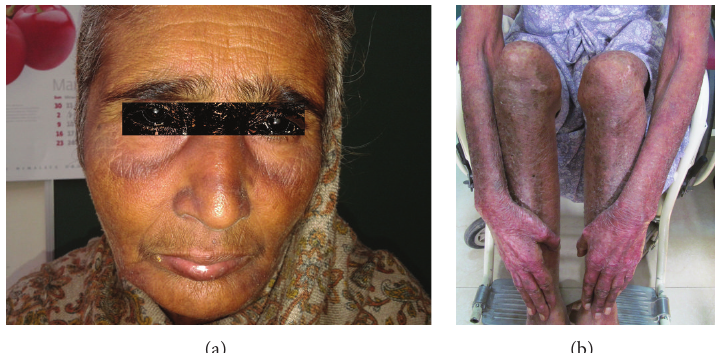
Figure 1: (a) Heliotrope rash in periorbital region. (b) Poikilodermatous changes evident on dorsolateral aspects of bilateral forearms.